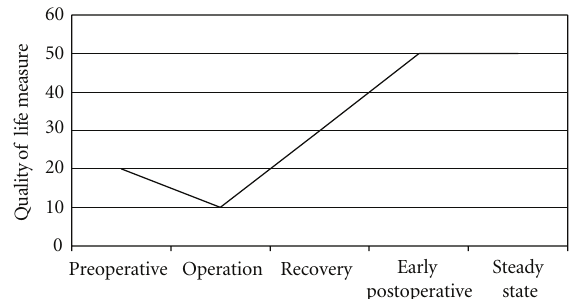
Figure 1: Hypothetical quality of life measurement after an operation for a disease. After initial fall in quality of life related to the operation, as the patient recovers, quality of life will improve to a level better than the patient’s preoperative status.